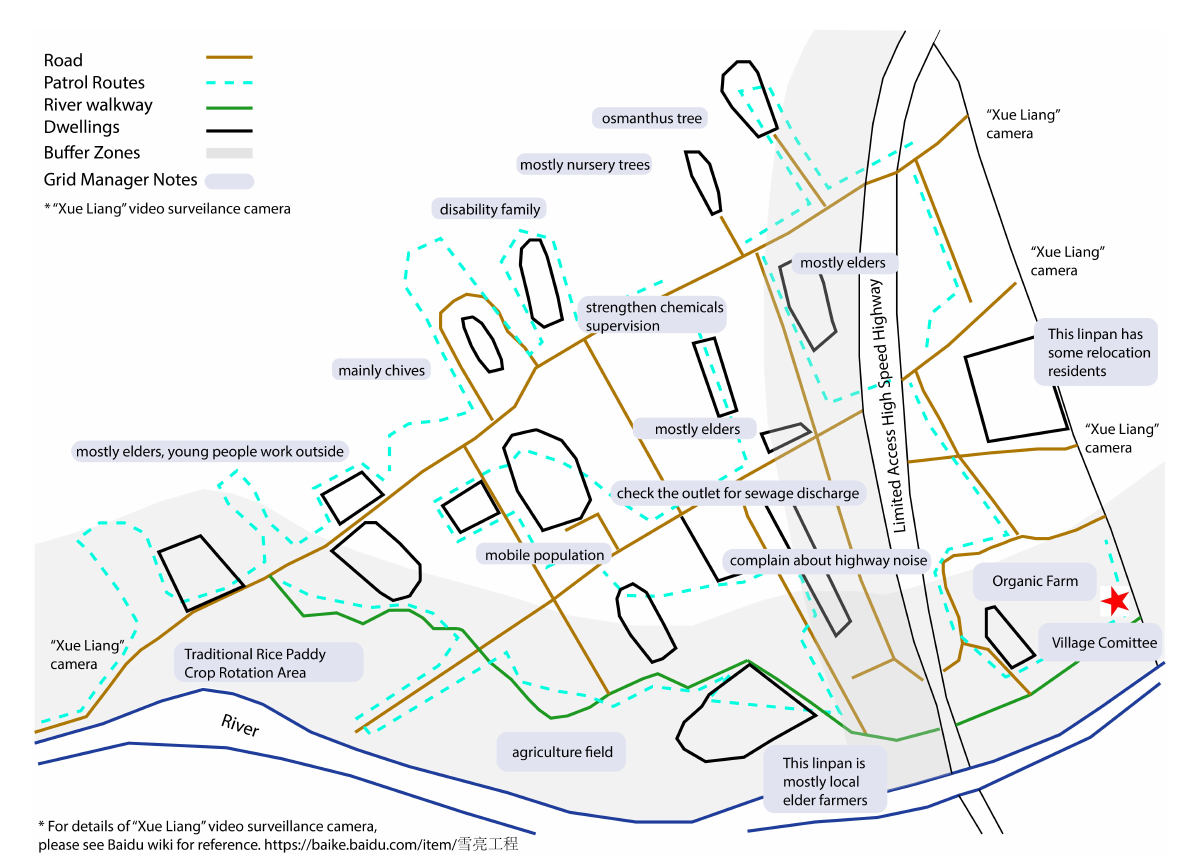
FIGURE4 A patrol map of a grid manager in W Village (drawn by the grid manager, modified by the author). The map drawn by Mr. Wei reveals bottom-up data generation that is very fine-grained, providing details and interpretation of the place through his